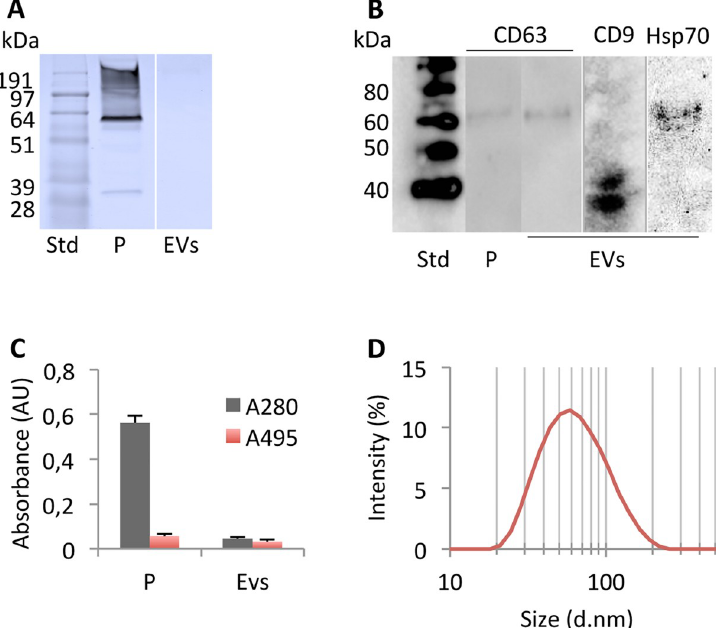
Fig 1. Characterization of isolated EVs. EVs originating from human plasma was isolated by SEC using qEV columns (iZON). Plasma (P) and EVs were separated by Bolt ready made 10% gels at denaturing conditions and stained with CBB (A). Proteins were transferred to a NC membrane and incubated in 1˚ Ab CD63, CD9 and Hsp70 produced in rabbit (1:1000) and 2˚ Ab Goat anti-Rabbit HRP (1:20000) (B). To determine the protein to vesicle ratio absorbance at 280 nm (grey) and 498 nm (red) were determined using a SpectraMax 1 Paradigm 1 Multi-Mode Microplate reader (Molecular devices) (C). The size and poly-dispersity of the isolated vesicles were analyzed in a Zetasizer Nano ZSP instrument (Malvern, UK)